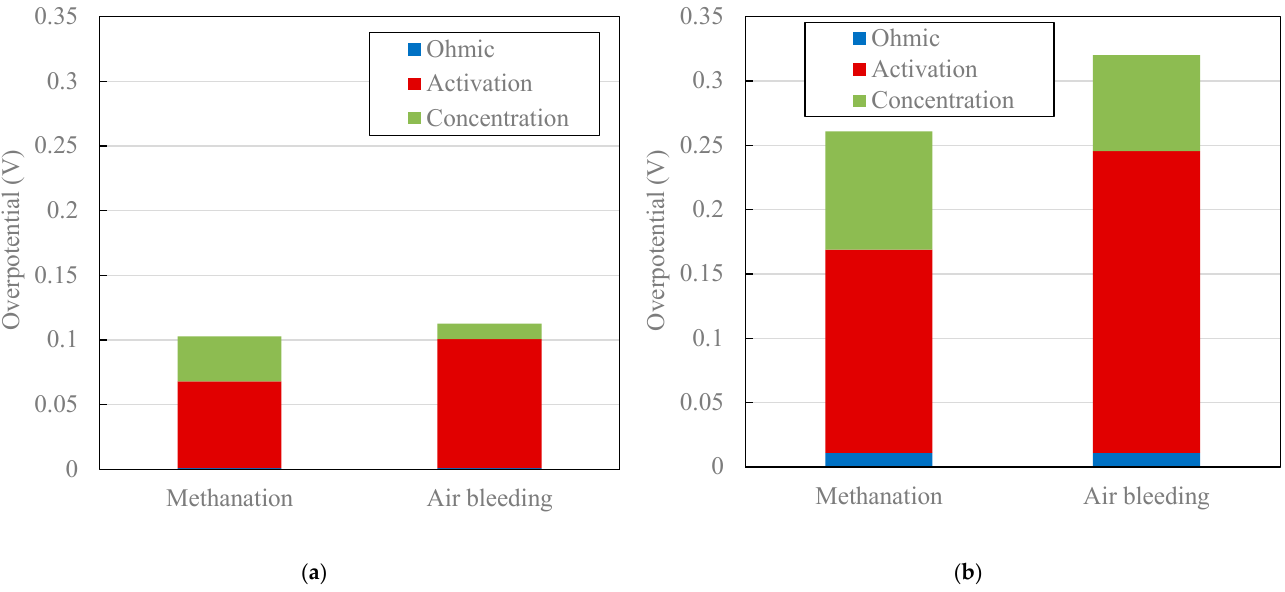
Figure 11. Comparison of the overpotentials at stoichiometry ratio 1.1 for each mitigation operation; ( a ) 0.6 A, ( b ) 8.0 A.